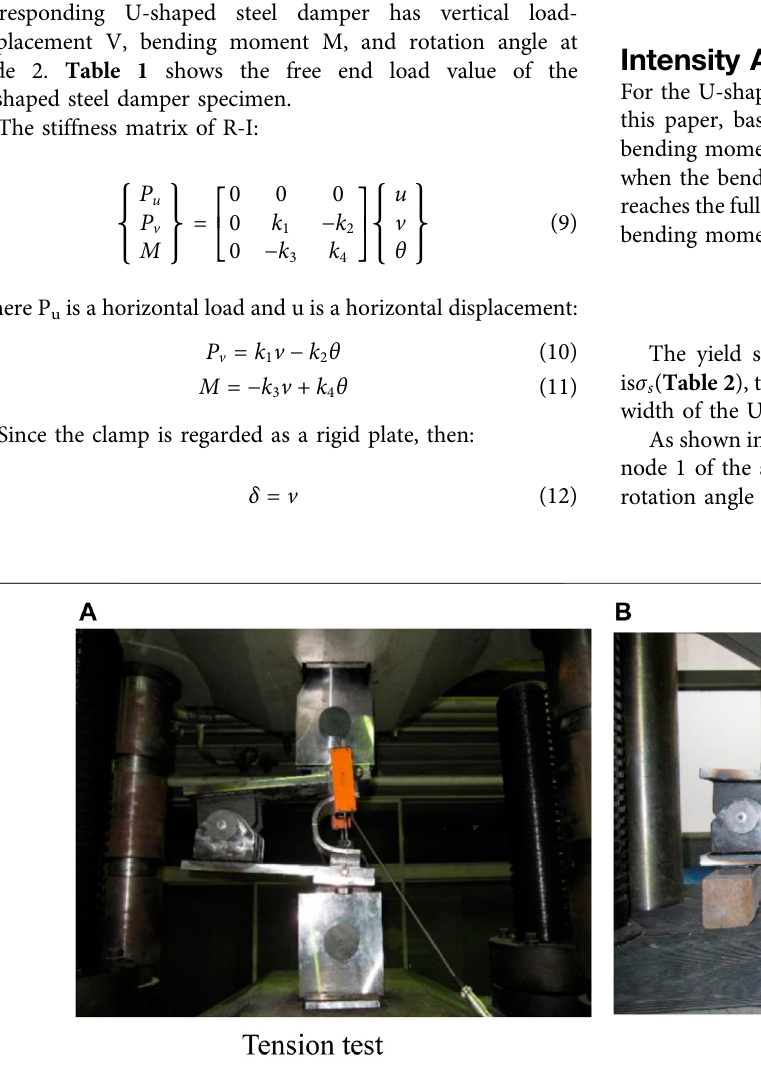
FIGURE 7 | Test device. (A) Tension test (B) Compression